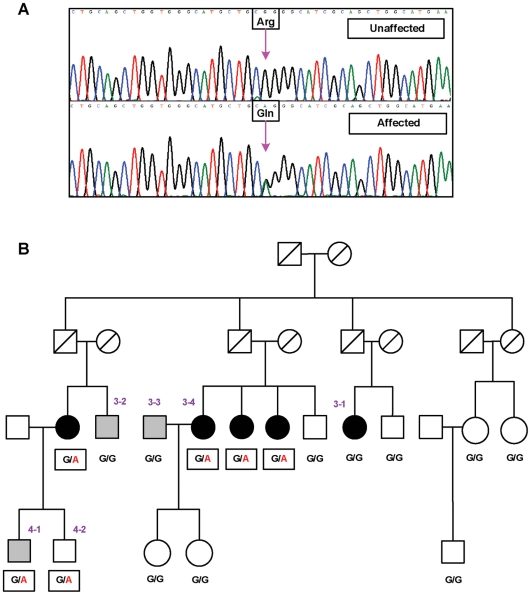
Characterization of a new coding variant Arg721Gln in exon 13.(A) An example electropherogram of the coding strand is displayed for an affected and an unaffected individual, with the arrow marking the variant. Individuals with disease were heterozygotes (CAG) for Gln/Arg while unaffected individuals were homozygotes for Arg/Arg (CGG). (B) A large family with cortical cataract was examined and the co-segregation of Arg721Gln with cortical cataract determined. Two members (3-1 and 3-2) and one marry-in (3-3) were GG (Arg/Arg) but have cortical cataract, suggesting phenocopies. Symbols filled with black or gray represent those affected with severe (≥25% of the lens affected) or moderate (5%≤score<25%) cortical cataract, respectively. In the parent generation, all heterozygotes for the Arg721Gln variant developed severe cortical cataract or have had cataract surgery. However, this variant has age dependent penetrance, as individuals who developed severe disease are older (e.g. individual 3-4 who is 80 years old). Individuals in the offspring generation who are at risk may not have developed full-fledged cortical cataract (e.g. 4-1 who is less than age 65 with moderate cataract, or 4-2 who is a carrier but remains free of disease at age 63).